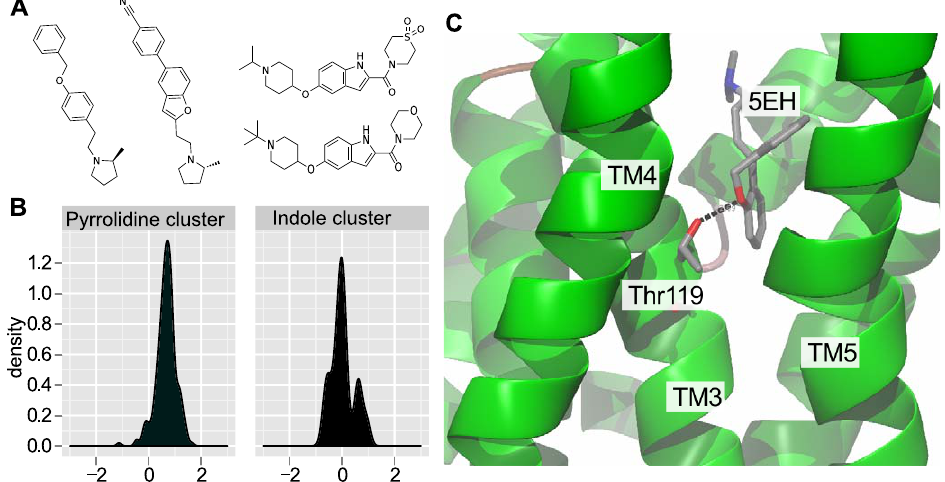
Figure 5. Species specific binding of small molecules for the HRH3. (a) Exemplary compounds from two clusters are shown. (b) Distributions of differences observed for compounds from the two respective clusters. Pyrrolidine containing componds bind the human target with higher affinity, while most compounds with an indole scaffold bind the human and rat HRH3 with equal affinity. (c) The substitution Thr119Ala is represented by a grey threonine side chain in the human receptor. The displayed ligand is the HRH1 antagonist Doxepin (5EH) and the nearest distance to Thr119 is 2.7A.